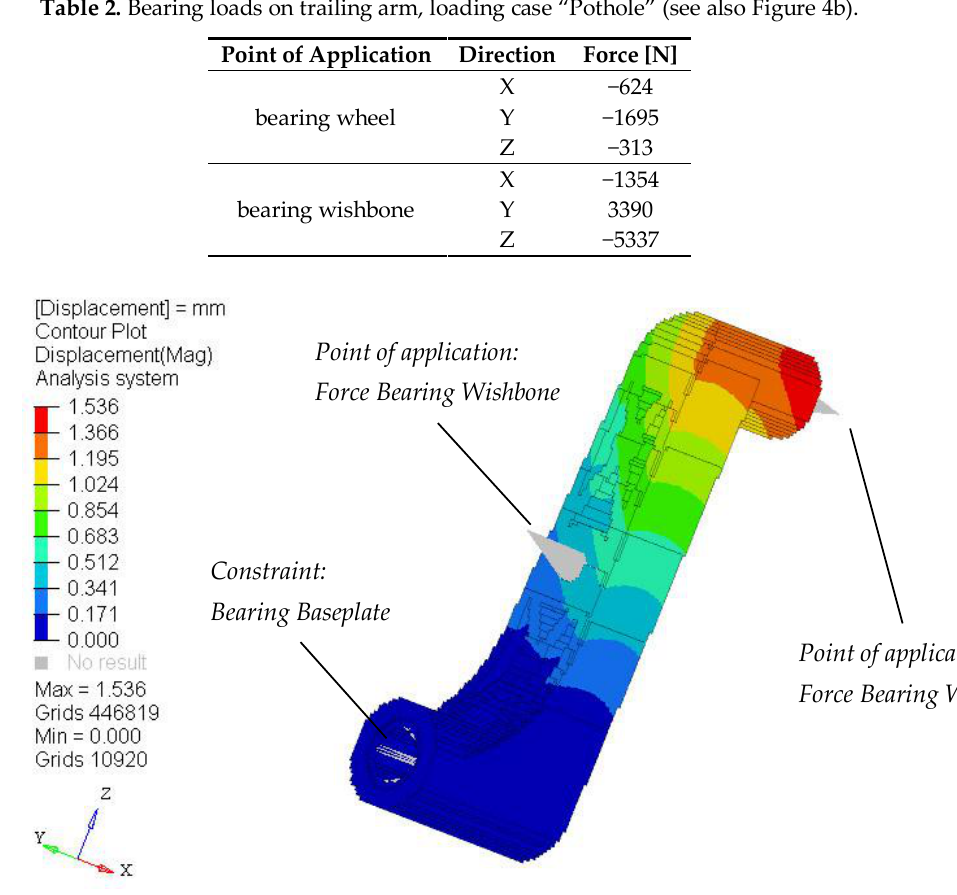
Figure 2. Static deflection of original trailing arm